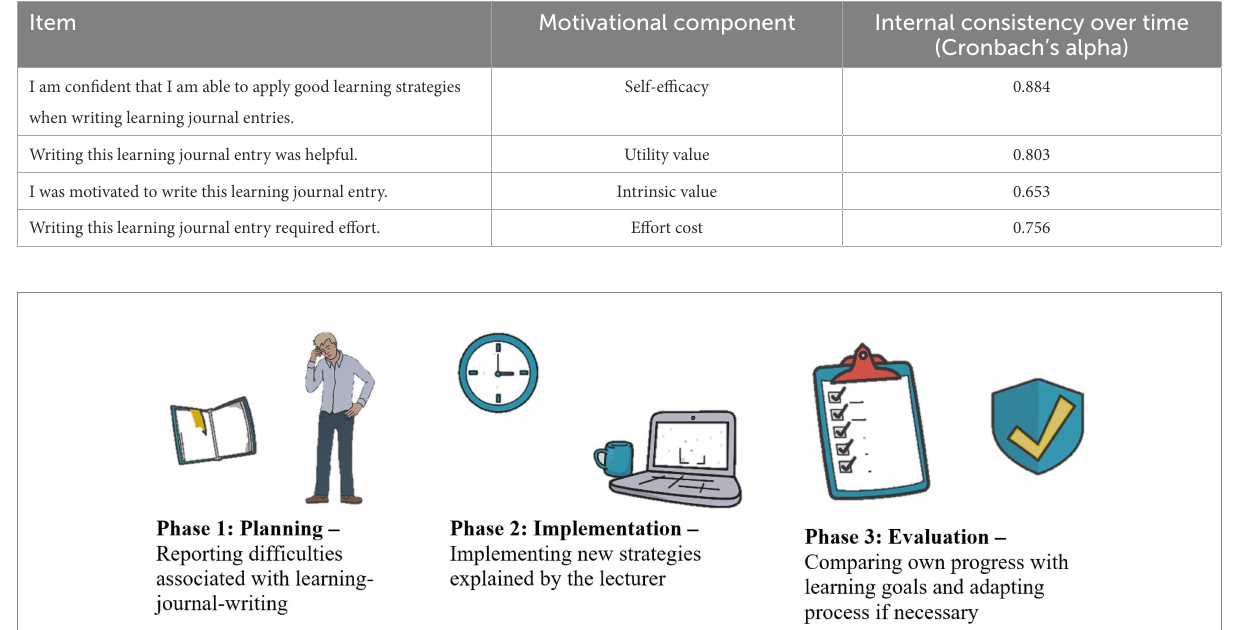
FIGURE 2 Screenshots from one of the sketched explanation videos explaining different strategies for writing learning journals.